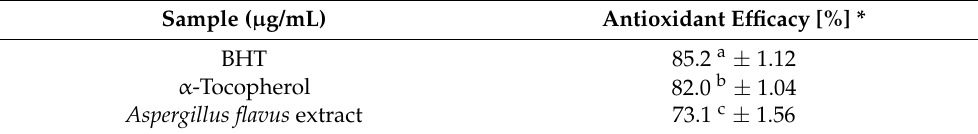
Table 1. Antioxidant activity of the ethyl acetate extract of fermented rice (koji) using A. flavus